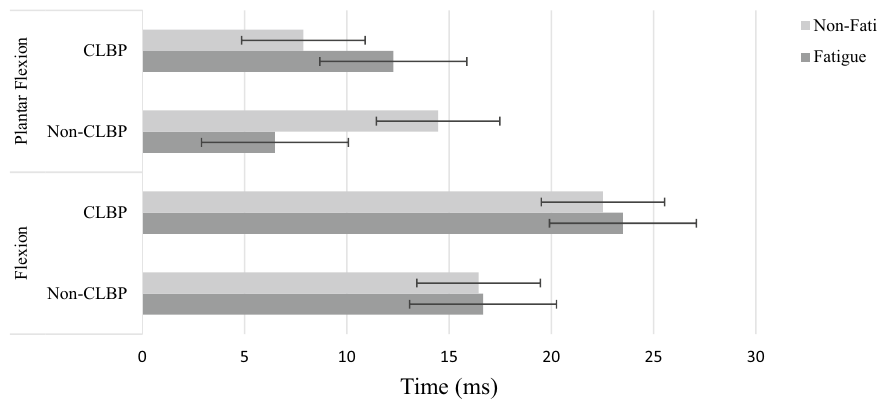
Figure 5. TRT for each muscle by groups (CLBP and Non-CLBP) in non-fatigued and fatigued. Flexion: Knee flexion, Plantar Flexion: Ankle Plantar Flexion.